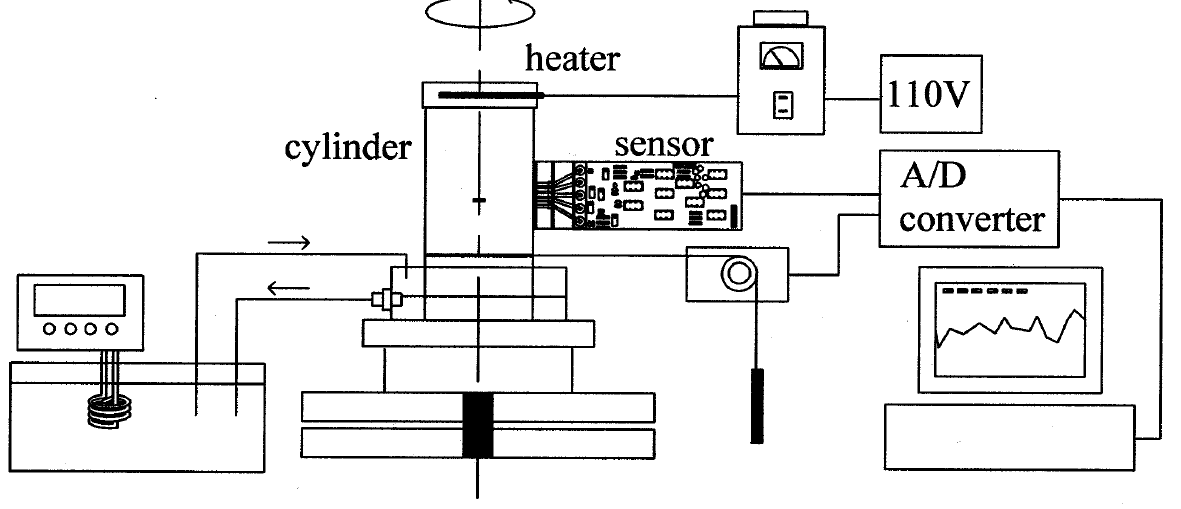
Figure 2. Schematic diagram of the experimental